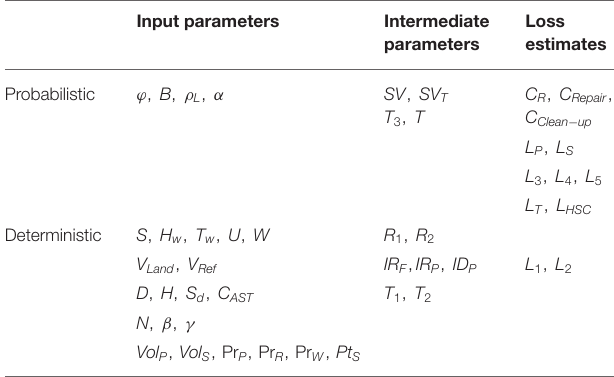
TABLE 1 | Parameters and estimation methods used in the loss analysis